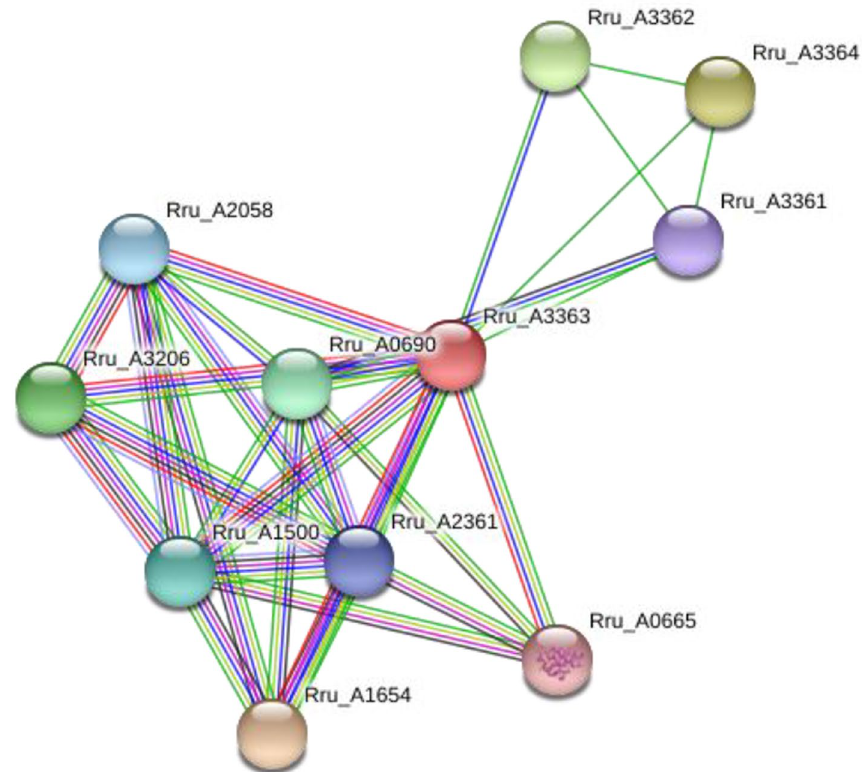
Fig. 5 Protein‑interaction network display, showing possible cognate functional partner proteins of RegO. Generated by STRING V.11 https:// versi on11. string‑ db. org/ cgi/ netwo rk. pl?